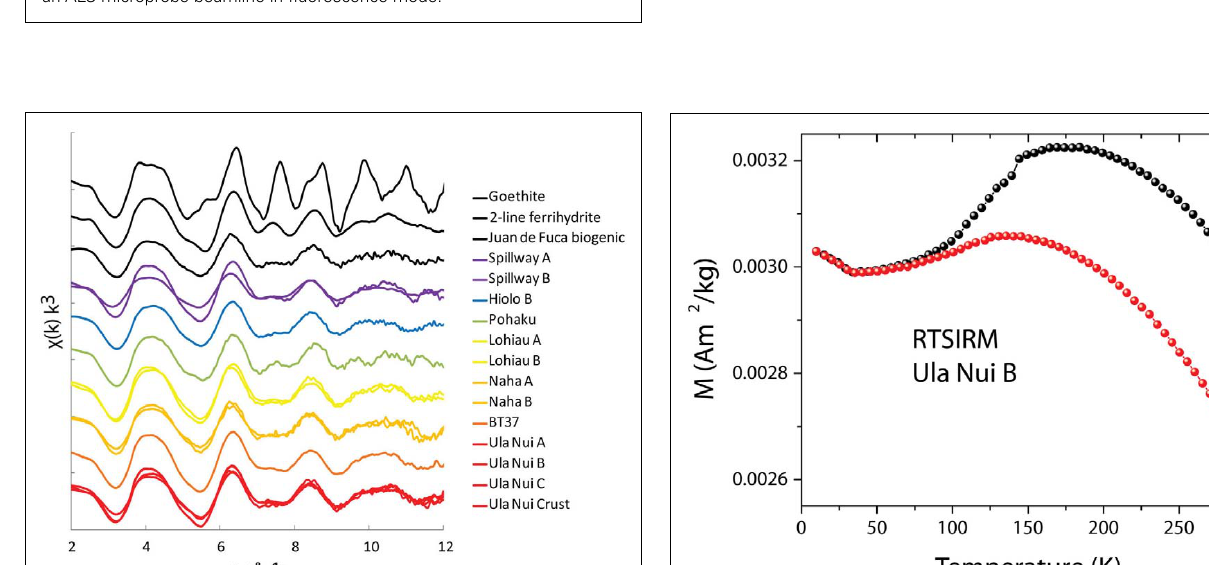
FIGUREA1 | Iron K-edge EXAFS spectra for the Ula Nui mats of Loihi Seamount having different sample handling and data collection conditions. The Ula Nui Crust was stored and analyzed frozen under N 2 at an SSRL microprobe beamline in fluorescence mode. Ula Nui-A/B were stored frozen, thawed, rinsed, and dried at 40˚C with analysis at the APS at a bulk beamline in transmission mode. Ula Nui C was stored in ambient seawater at 4˚C for 6months, and was analyzed as rinsed/air-dry particles at an ALS microprobe beamline in fluorescence mode.